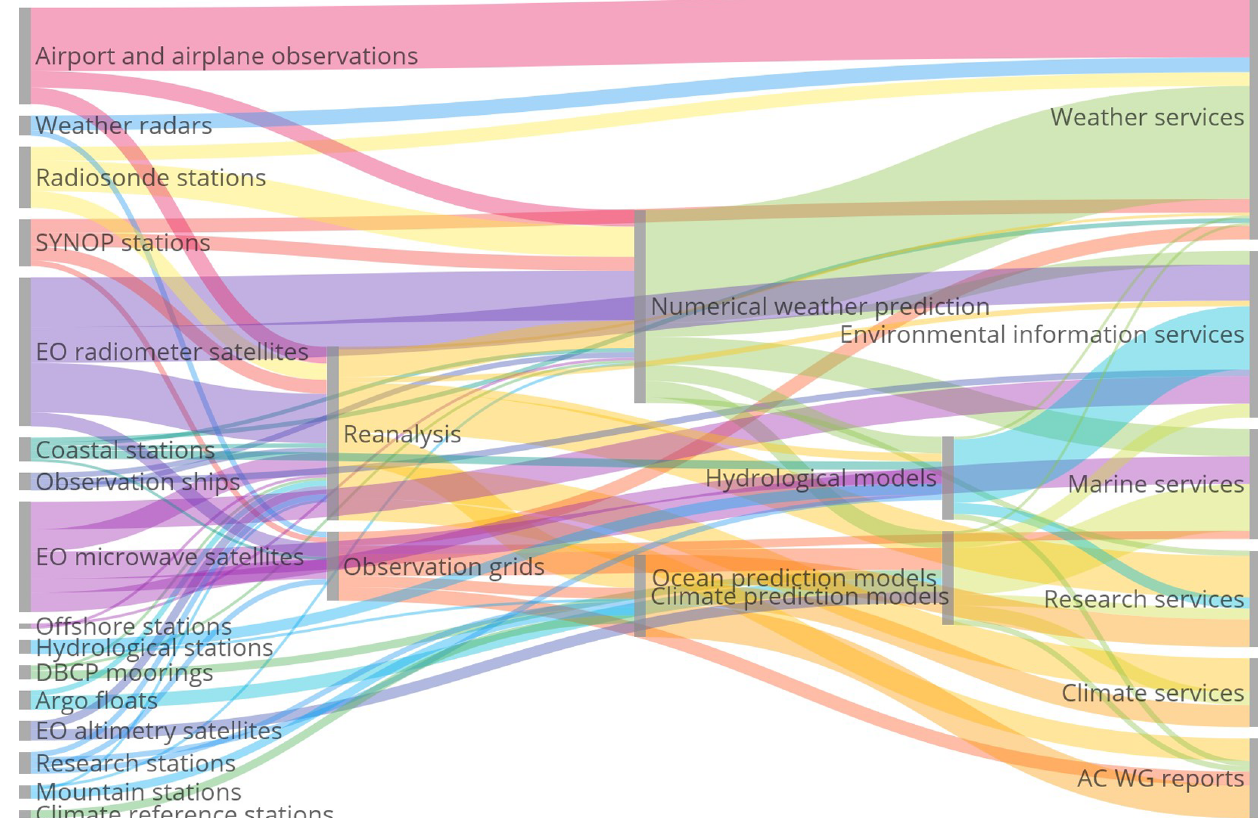
Figure 30. The observations, modeling, and service parts of the value tree – the source tree; iCUPE actions are represented in research stations, EO satellites, and observation grids supporting research services. The framework foresees three levels, but modeling feeds its own components, which adds more depth to the tree. The observations (left side) originate from different platforms, such as airplanes, ships, surface synoptic observations (SYNOP), Data Buoy Cooperation Panel (DBCP) moorings, Argo floats, or Earth observations (EOs) from satellites. Some observations are utilized in services directly, and some are integrated into observation grids, or they provide data for reanalysis. The combination of observations and various models provides the required data for the different services (right side), such as weather, marine, and climate services as well as, e.g., data for Arctic Council Working Group (AC WG)